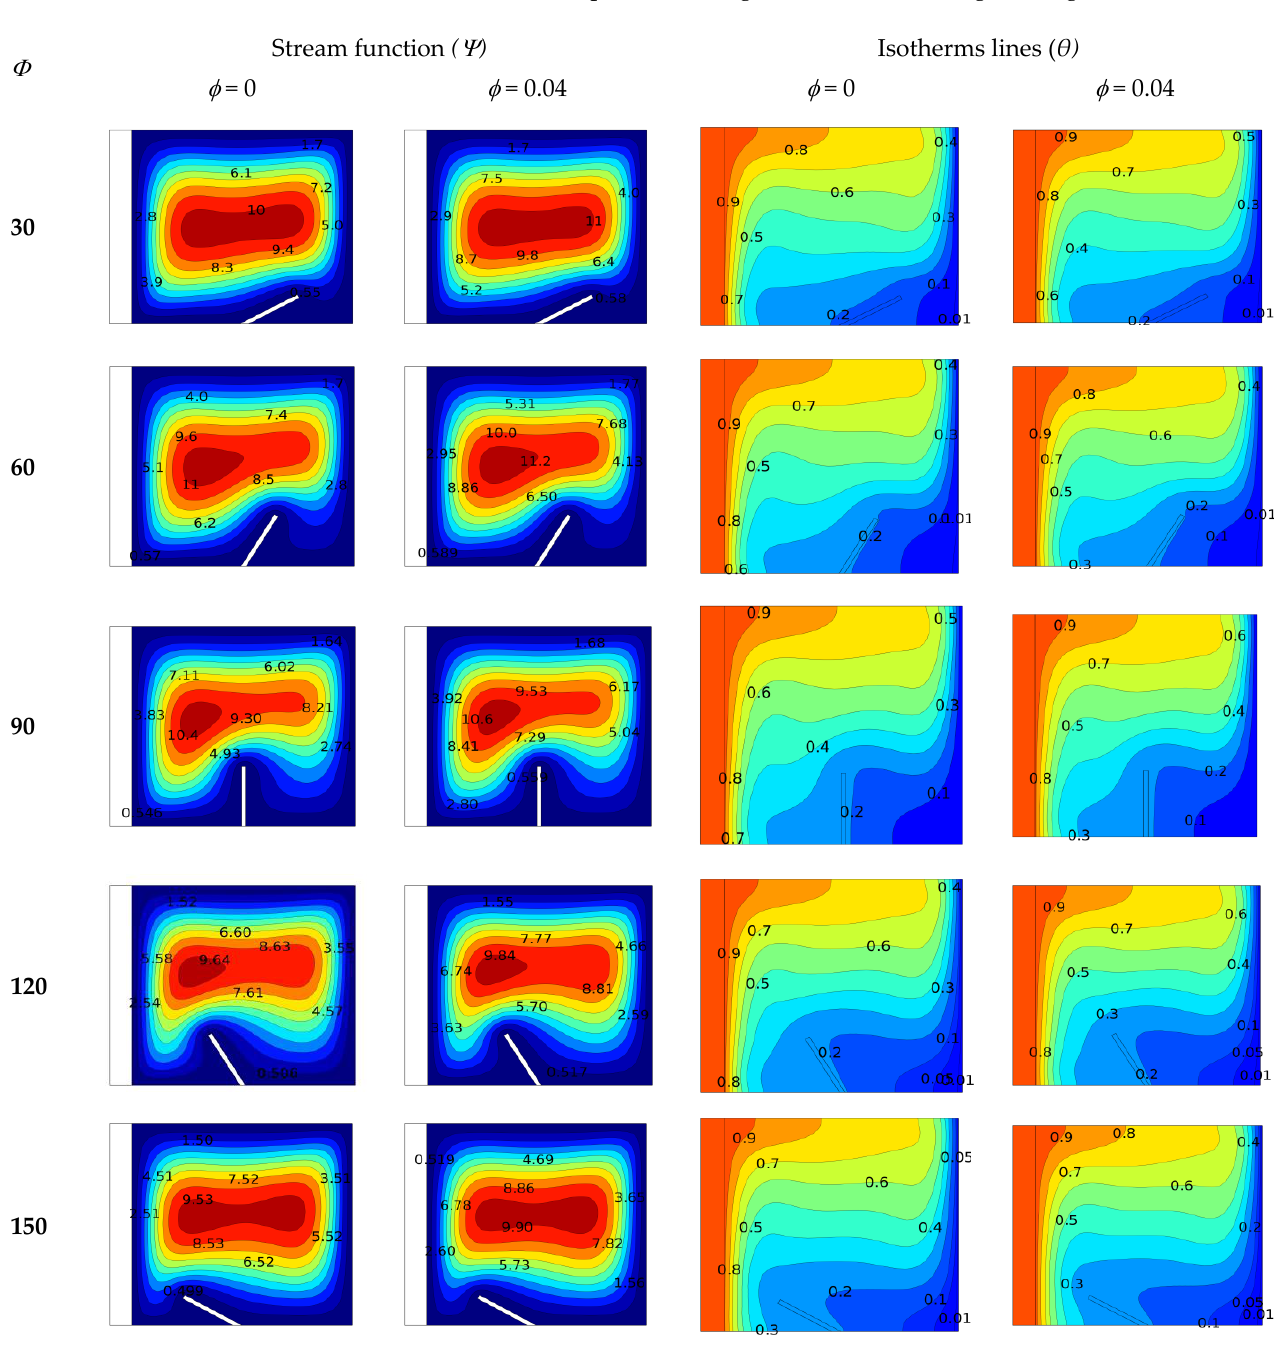
Figure 7. Effect of baffle inclination angle ( Φ ) on streamlines (two left columns) and isotherms (two right columns) for different value of solid volume fraction with Ra = 10 5 and Kr = 10. From the two columns on the right of Figure 7, it can be observed that as the angle of the baffle reaches the value of ( Φ = 30 ) , the blocking effect of the baffle on the